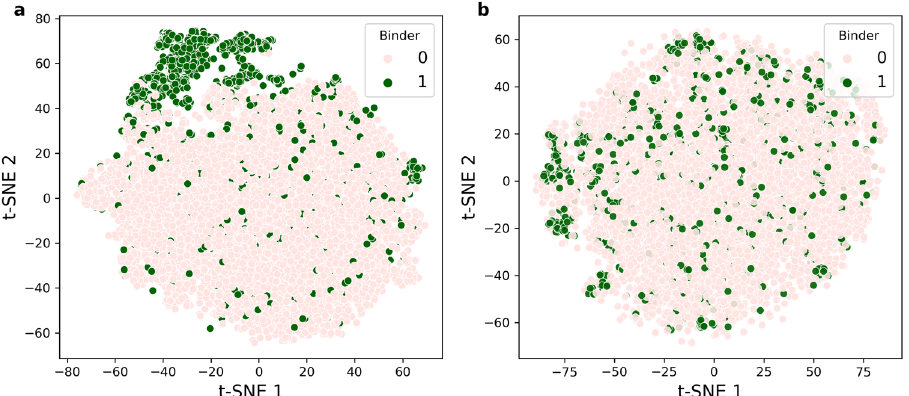
Fig. 6 t-SNE plot for the TCRs of the GIL peptide. a The output from the max-pooled CNN layer of NetTCR trained on the 90% partitioned data set was extracted for each TCR speci fi c to the GIL peptide using cross-validation, resulting in a set of vectors, each of dimension 160. T-SNE was used to visualize this data set in two dimensions. b In the input space, the TCRs were encoded using a 5-feature physicochemical encoding and then fl attened into a vector. The perplexity hyperparameter of the t-SNE algorithm was chosen to be 40 and the number of iterations was set to 1000. In the plot, positive TCRs are shown in green, and negative TCRs in pink.